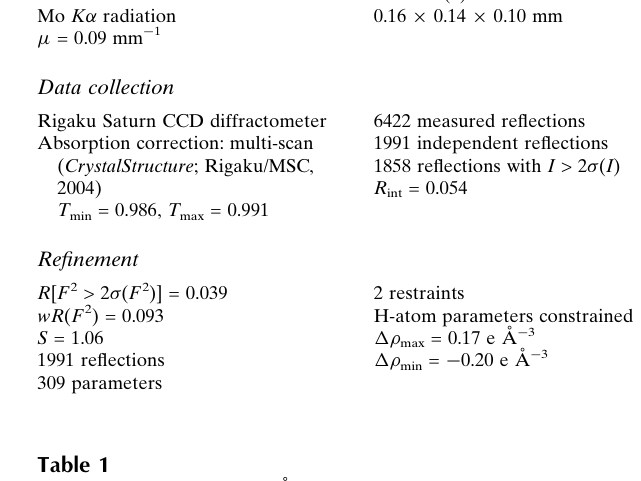
Rigaku Saturn CCD diffractometer Absorption correction: multi-scan